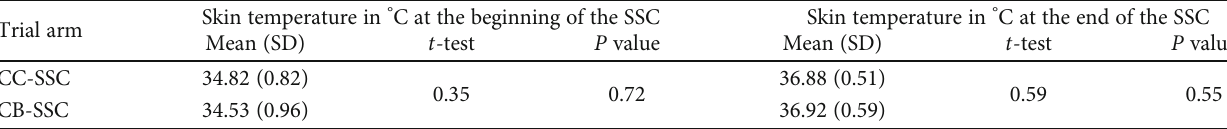
Table 3: Mean skin temperature of newborns when measured in both the groups at the beginning of SSC and at the end of SSC.